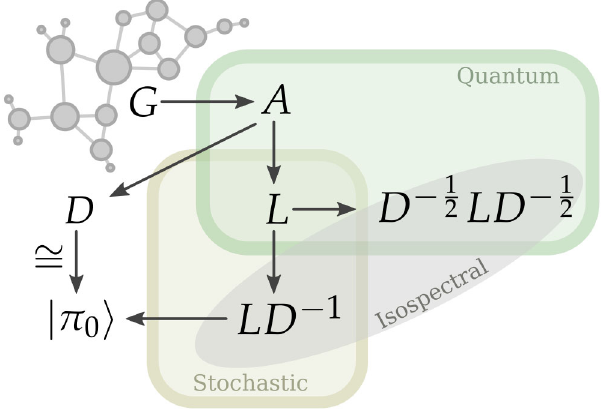
FIG. 1. Relating stochastic and quantum walks. An undirected weighted network (graph) G is represented by a symmetric, off- diagonal and non-negative adjacency matrix A . There is a map- ping from A (by summing columns) to the diagonal matrix D , with entries given by the weighted degree of the corresponding node. The node degrees are proportional to the steady-state probability distribution of the continuous-time stochastic walk (with uniform escape rate from each node) generated by H C ¼ LD (cid:1) 1 , where L ¼ D (cid:1) A is the Laplacian. The steady-state probabilities, represented by the vector j (cid:1) 0 i , are proportional to the node degrees. We generate a corresponding continuous- time unitary quantum walk by the Hermitian operator H Q ¼ D (cid:1) 1 = 2 LD (cid:1) 1 = 2 , which is similar to H C . The probability of being in a node in the stochastic stationary state j (cid:1) 0 i and the proba- bility arising from the quantum ground state are equal and proportional to the node